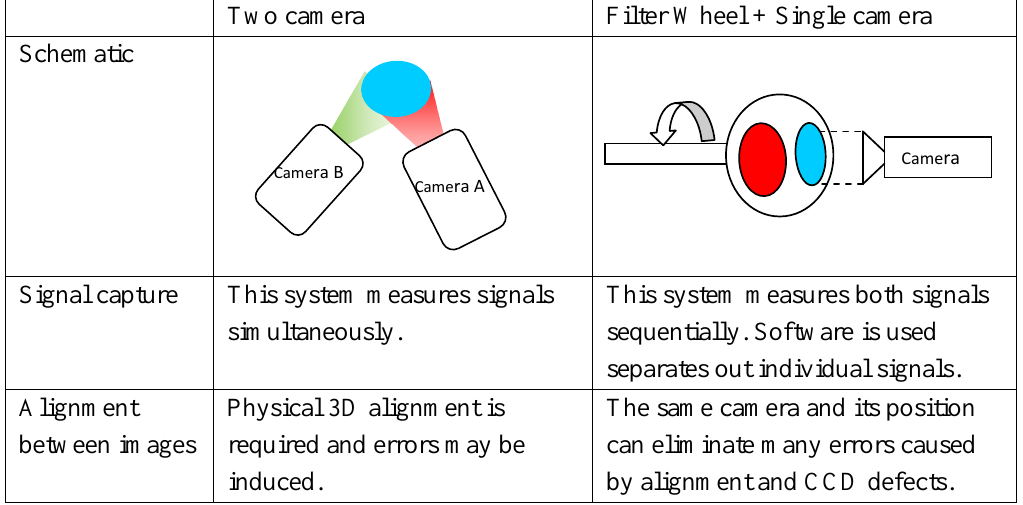
Table 5. Comparison of the ‘conventional two camera’ approach and the ‘filter wheel approach’ detection for the two-mode intensity